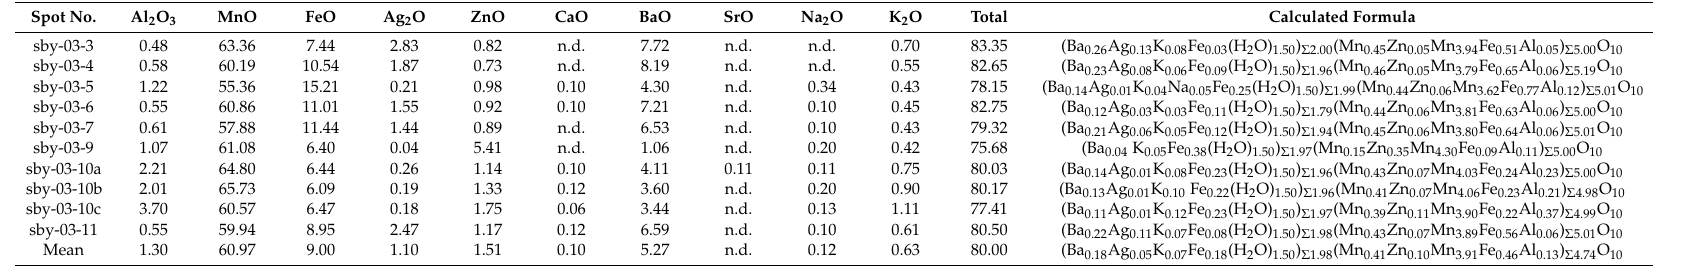
Table 3. Electron probe X-ray microanalysis (wt.%) of massive roman è chite from the Sanbao deposit. Spot No.